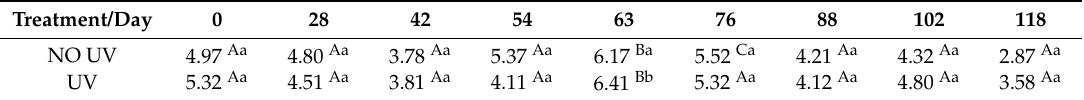
Table 2. Log 10 of aerobic plate counts of the ultraviolet (UV) sterilizer and non-ultraviolet (No-UV) sterilized lettuce samples over the 118 days in an aquaponic model system. Treatment/Day